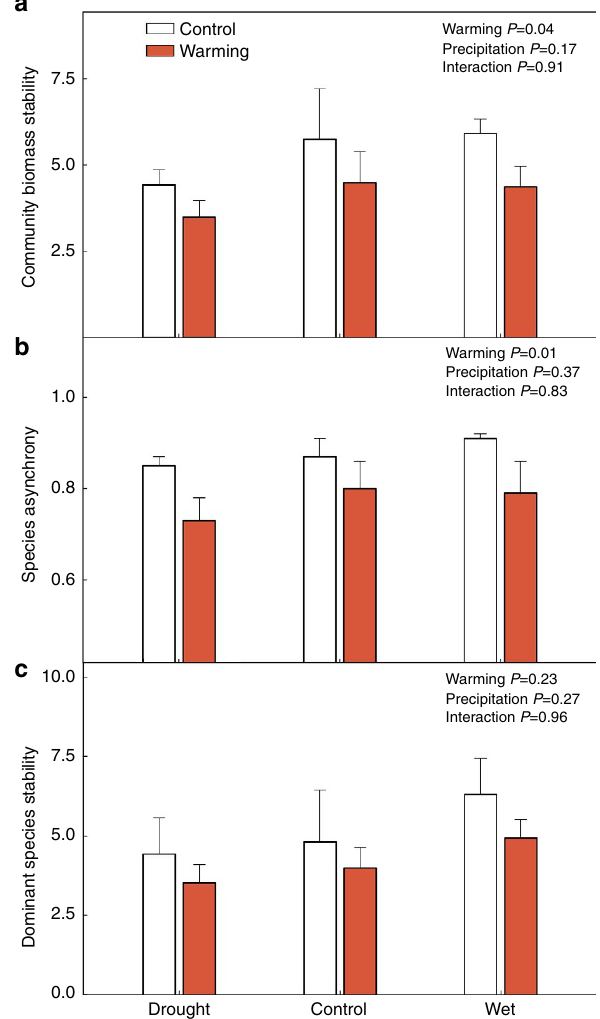
Figure 2 | Temporal stability and species asynchrony in different experimental treatments. Shown are ( a ) community biomass temporal stability (linear mixed-effects model; warming: P ¼ 0.04; precipitation: P ¼ 0.17; interaction: P ¼ 0.91); ( b ) species asynchrony (linear mixed- effects model; warming: P ¼ 0.01; precipitation: P ¼ 0.37; interaction: P ¼ 0.83); and ( c ) dominant species stability (linear mixed-effects model; warming: P ¼ 0.23; precipitation: P ¼ 0.27; interaction: P ¼ 0.96) in the warming and altered precipitation treatments during the experimental period. Drought, 50% reduction in precipitation compared with control; Wet, 50% increase in precipitation compared with control. Vertical bars represent the s.e.m. ( n ¼